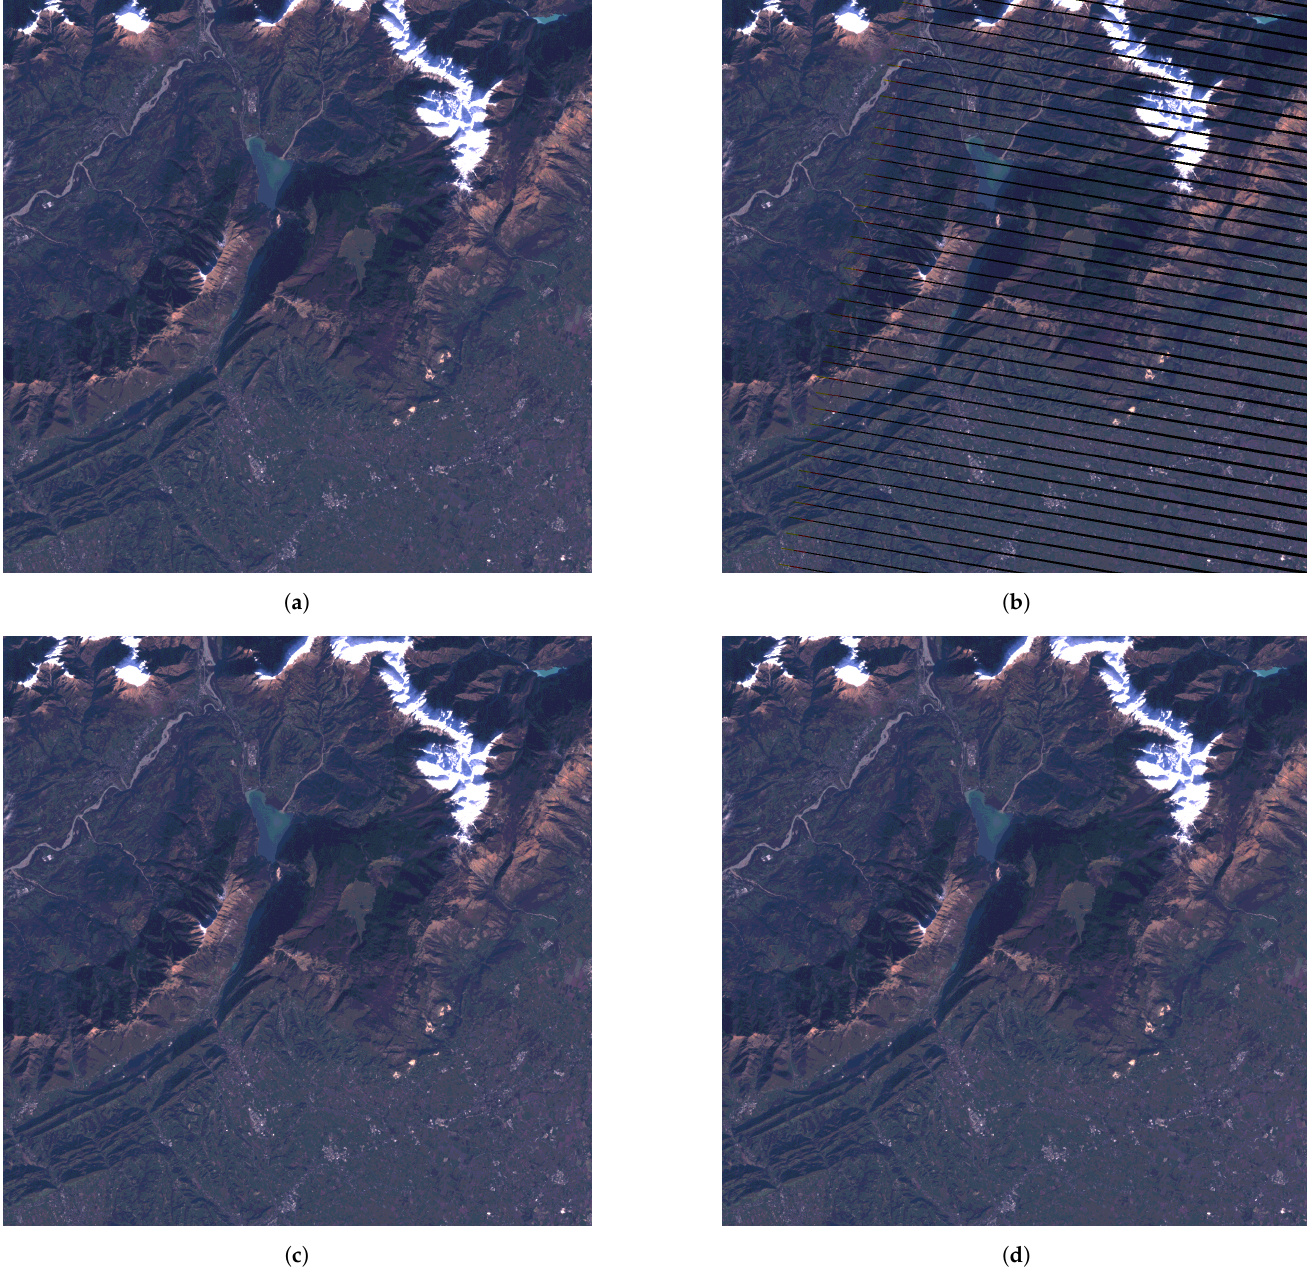
Figure 10. Base, target, HM, and ED reconstructions of the RGB band set of Landsat 7 LE71920282000332NSG00 scene. ( a ) base image; ( b ) target image; ( c ) HM reconstruction; ( d ) ED